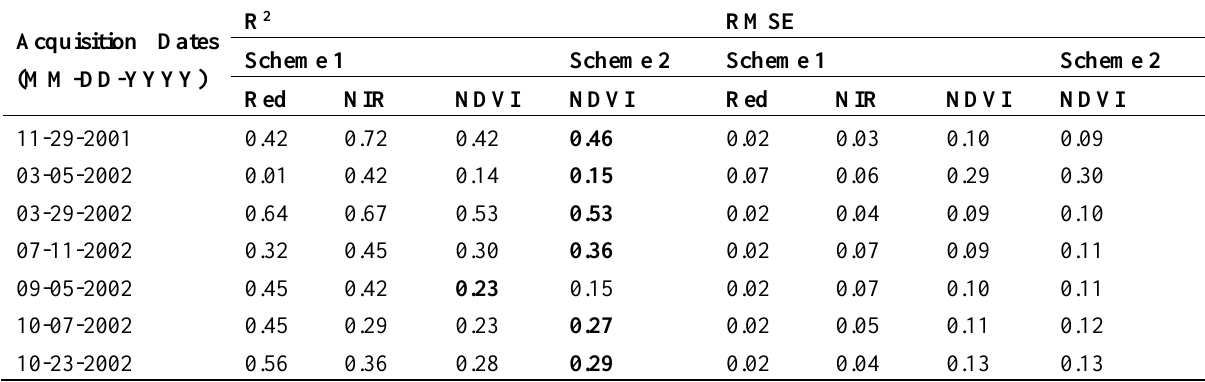
Table 1. Results of the pixel-based regression of the reference Landsat images versus the predicted images by two schemes for seven acquisition dates. The better result for each date is shown in